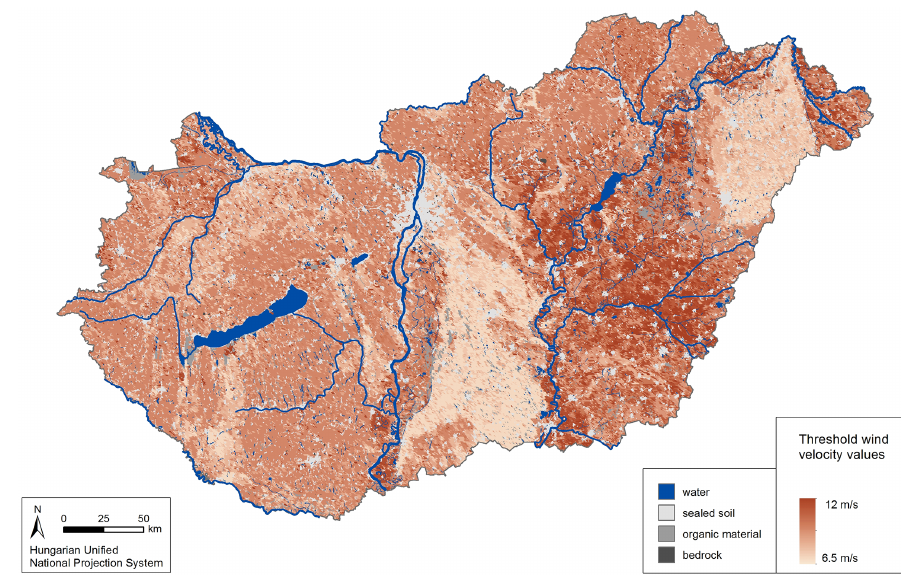
Figure 6. Threshold wind velocity values linked to the centres of the 0.5 (cid:48) resolution grid based on the soil texture